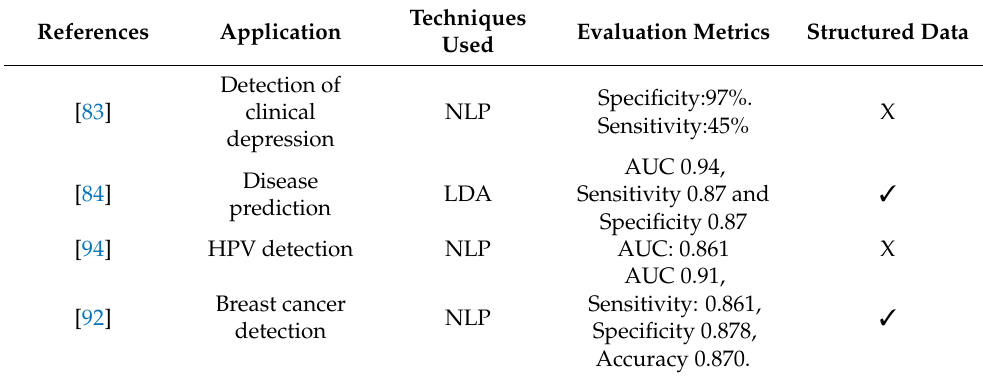
Table 4. Comparison of unstructured